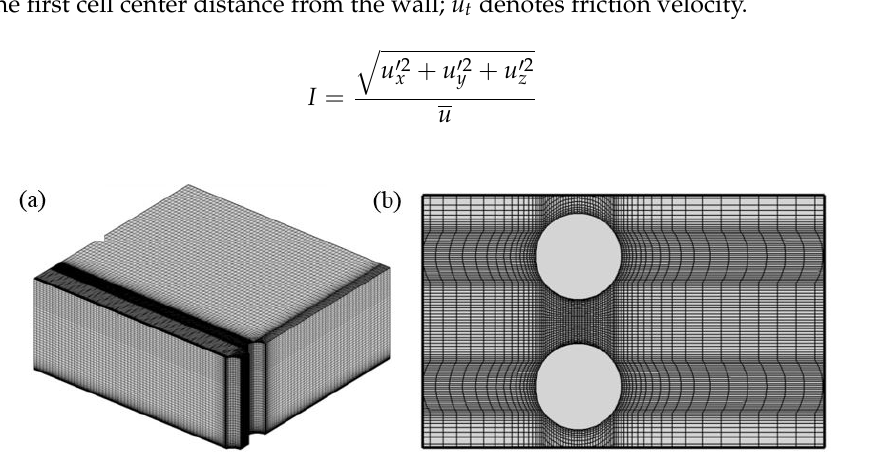
Figure 2. Grid used for the simulations at two positions: ( a ) part of the upstream computational domain, and ( b ) near the two cylinders.